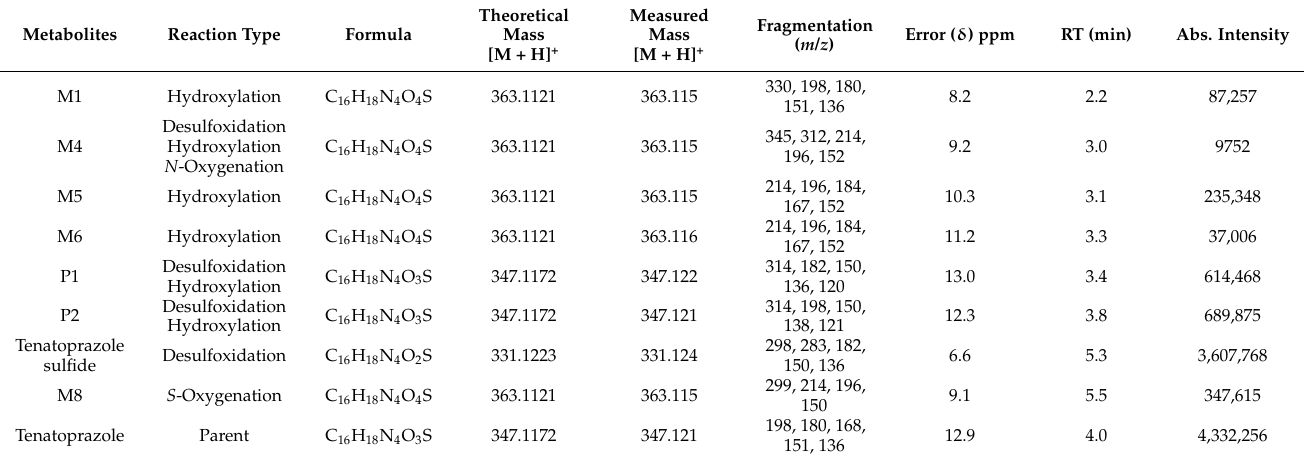
Figure 3. LC-QTOF-MS analyses of the metabolites from the tenatoprazole oxidized by HLMs. The extracted ion chromatograms were constructed by incubating tenatoprazole with HLMs in the absence ( A ) and presence ( B ) of NADPH. Table 1. Characteristics of tenatoprazole metabolites of HLMs by